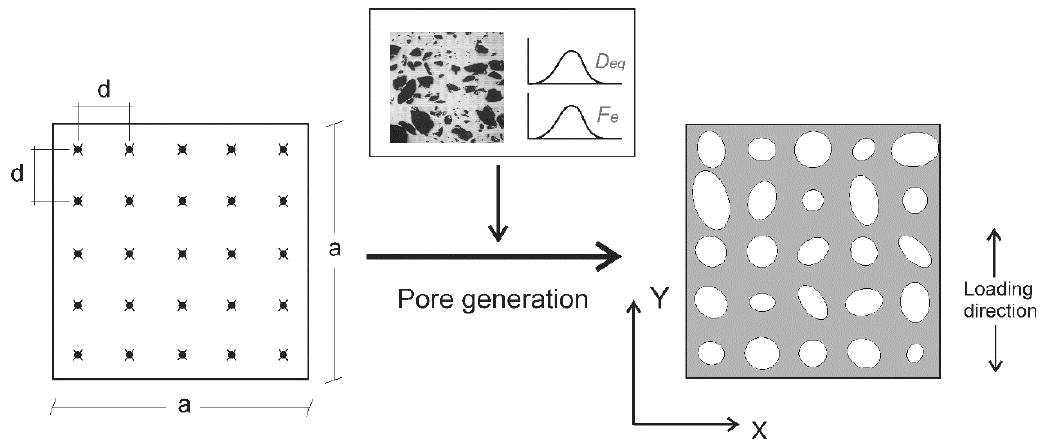
Figure 1. Geometry generation for finite element (FE) model.